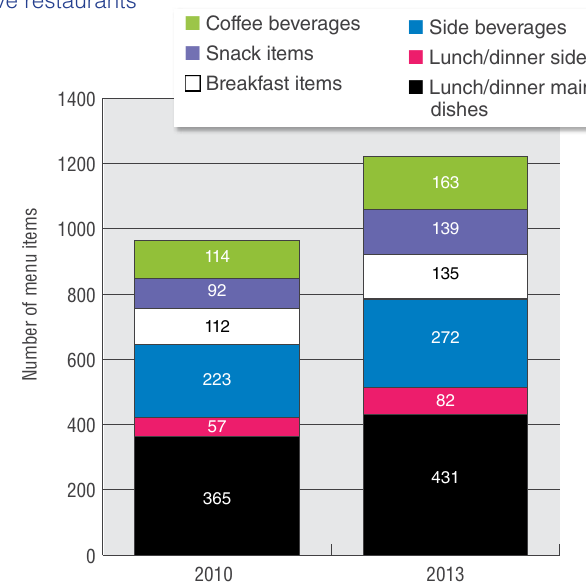
Figure 2. Number of menu items offered by type for the top- five